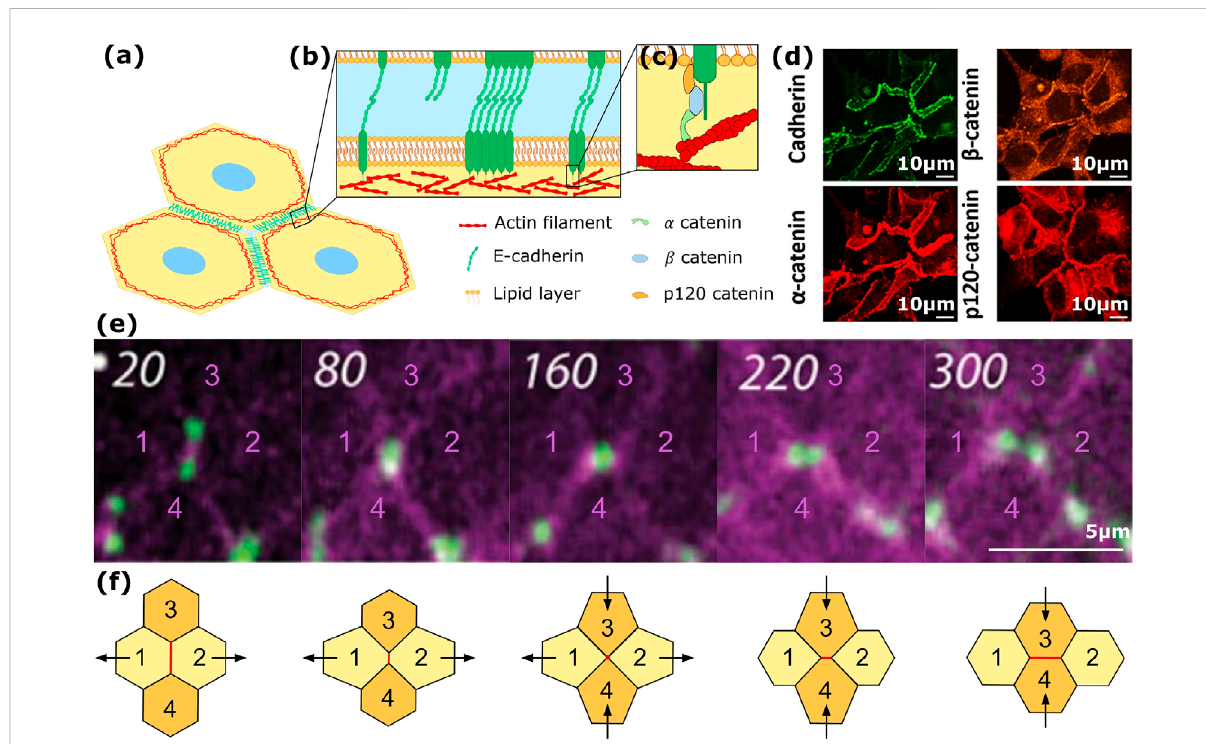
FIGURE 1 Cell-cell adhesion and rearrangements in tissues (A) Schematic representation of cell-cell adhesion in epithelial tissues mediated at adherens junctions by cadherin (green) and actin (red) co-action. (B) Zoom on the cadherin homophilic interactions in the extracellular vicinity of contacting cells: the cadherins interact both through trans adhesions between cadherins of opposing surfaces, and through cis interactions leading to lateral clusteringonthecellsurface. (C) Schematicrepresentationoftheanchorageoftheintracellulardomainsofcadherinstotheactincytoskeleton through β -catenin, α -catenin and p120-catenin. (D) Immuno fl uorescence microscopy images of α -catenin, β -catenin and p120-catenin in S180cellsexpressingGFP-taggedE-cadherin(green).Cadherinandcateninlinkerproteinsappearco-localizedatcellularjunctions[20]. (E) T1event observed inalive embryoinwhichthevertex speci fi cproteinsidekick (green)andtheDE-cadherin(purple)arelabelled.Thislabellingallows totrack the shrinking edge as the vertices come closer, down to the formation 4-way vertex. Eventually a new contact is grown and the new vertices progressively grow apart until the junction is matured [21]. (F) Schematic representation of a rearrangement in the form of a T1 event. First, the adhesive junction between cells 1 and 2 shrinks, all theways down to a point contact between the4 cells. Then, cells 1 and 2 fi nish moving apart and are no longer neighbors, while an adhesive contact between newly neighboring cells 3 and 4